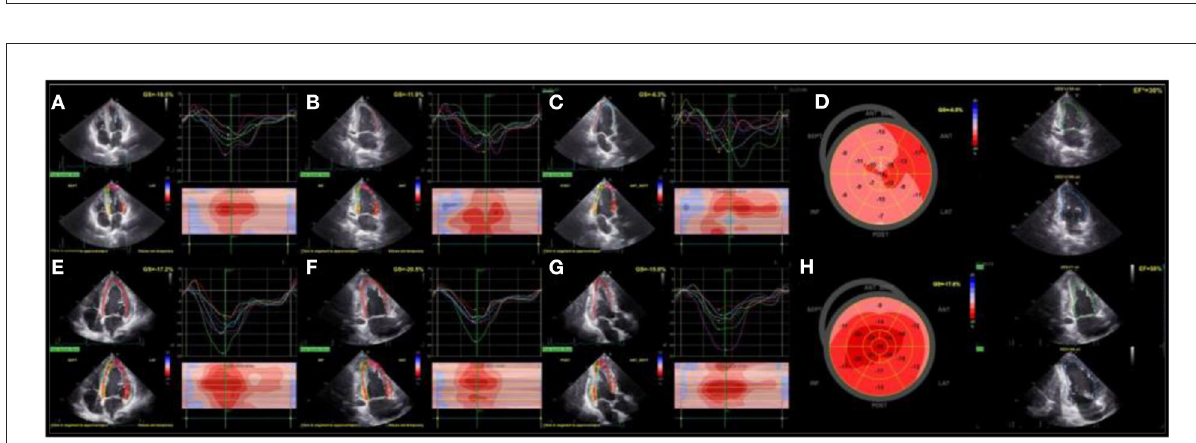
FIGURE4 Assessment of LV function with TTE (On the fifth day of admission): LV systolic function was severely impaired, including impaired and asynergic longitudinal deformations that can be appriciated from speckle tracking analysis of apical 4- chamber (A) , 2-chamber (B) , and 3-chamber (C) views and globally from polar map (D) . During the follow-up (eighteenth day), LV EF and longitudinal deformations significantly improved (E–H) . LV, left ventricle; TTE, transthoracic echocardiography; EF, left ventricular ejection